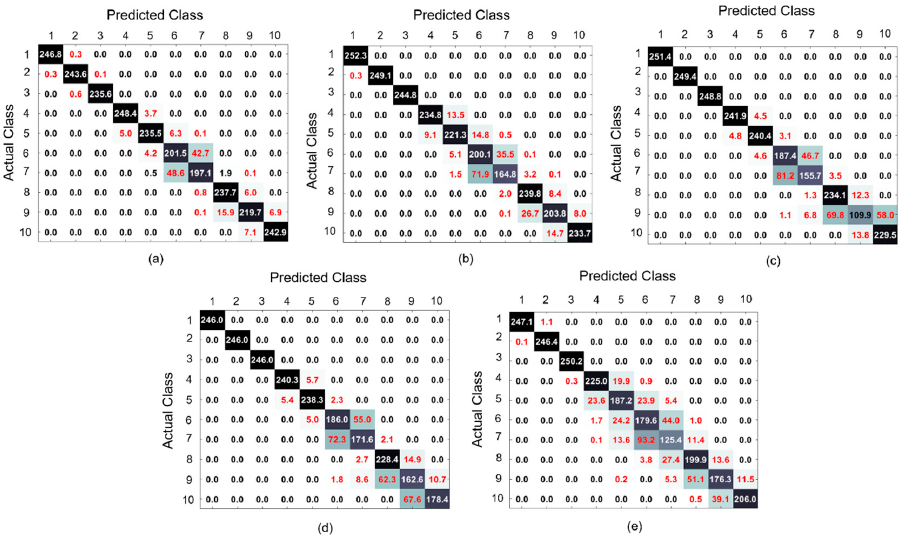
Figure 9. The confusion matrices obtained for ( a ) proposed, ( b ) autoregressive with external input ARX–Laguerre proportional–integral observer (PIO) (ARXLPIO)+DNN, ( c ) the characterization of